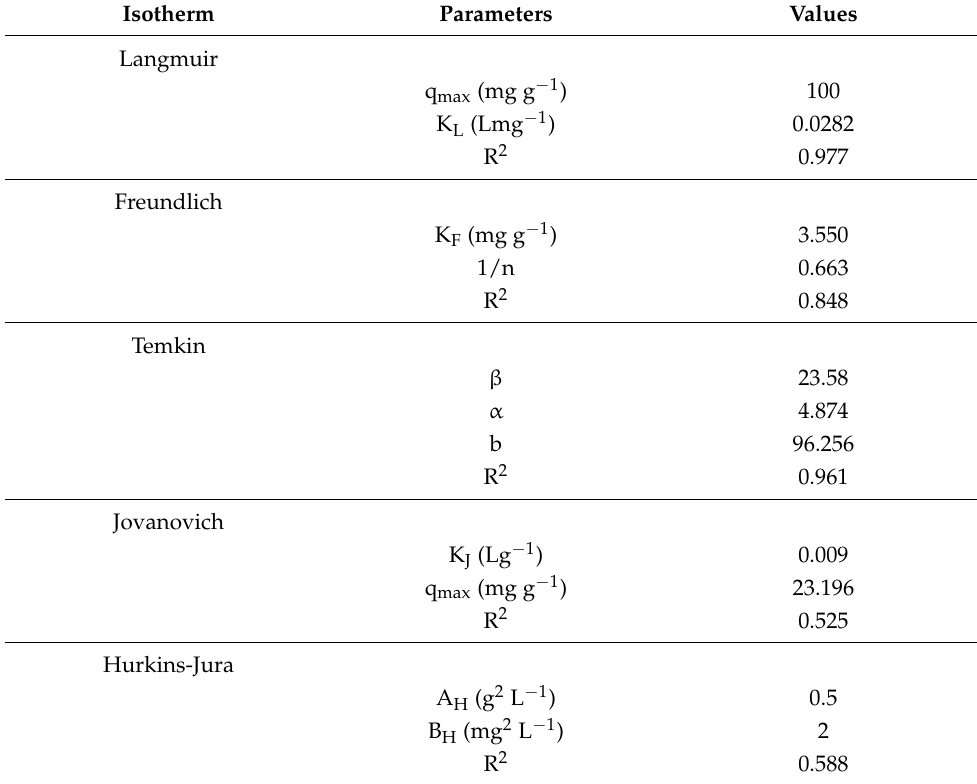
Table 2. Isothermal parameters for adsorption of Iron(II) on